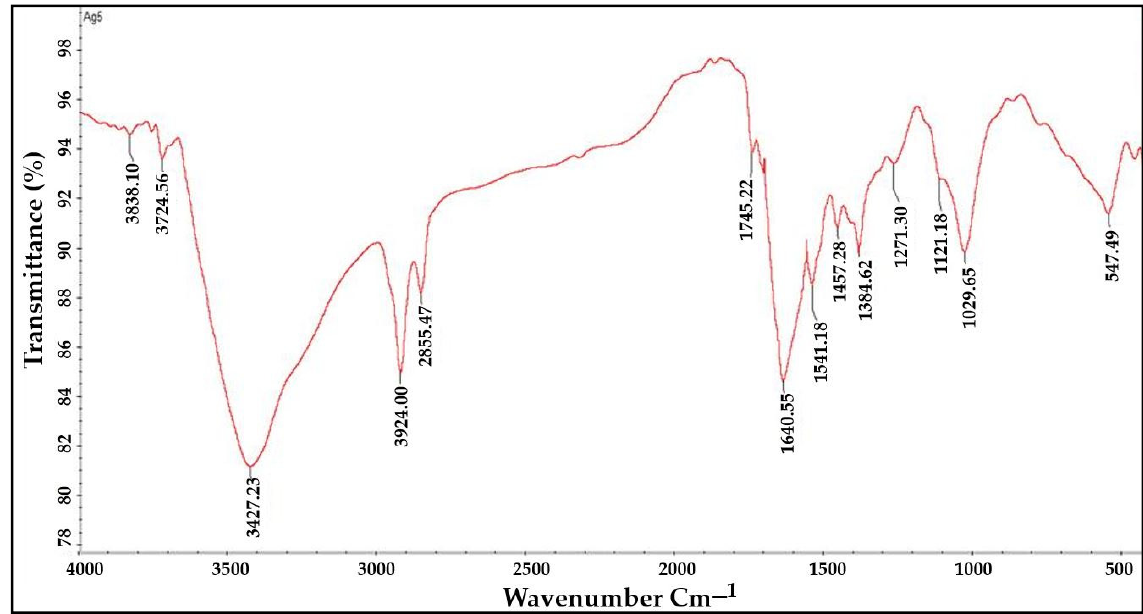
Figure 5. FTIR analysis of aqueous leaf extract of R. apiculata to determine its functional groups.